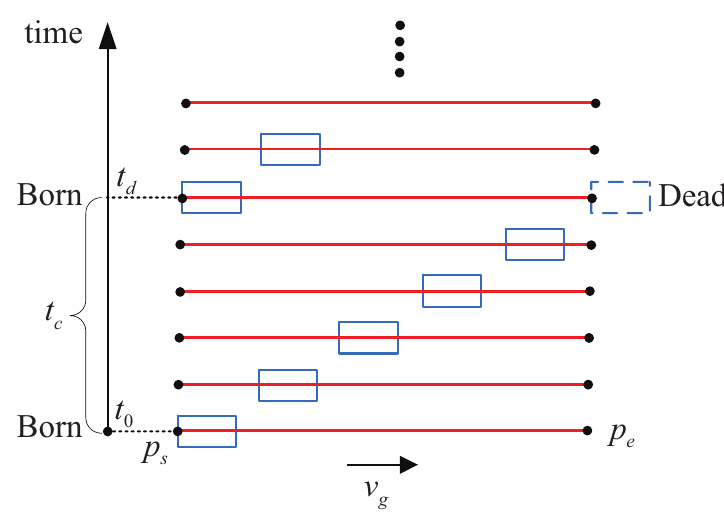
Figure 6. Motion of virtual grid.